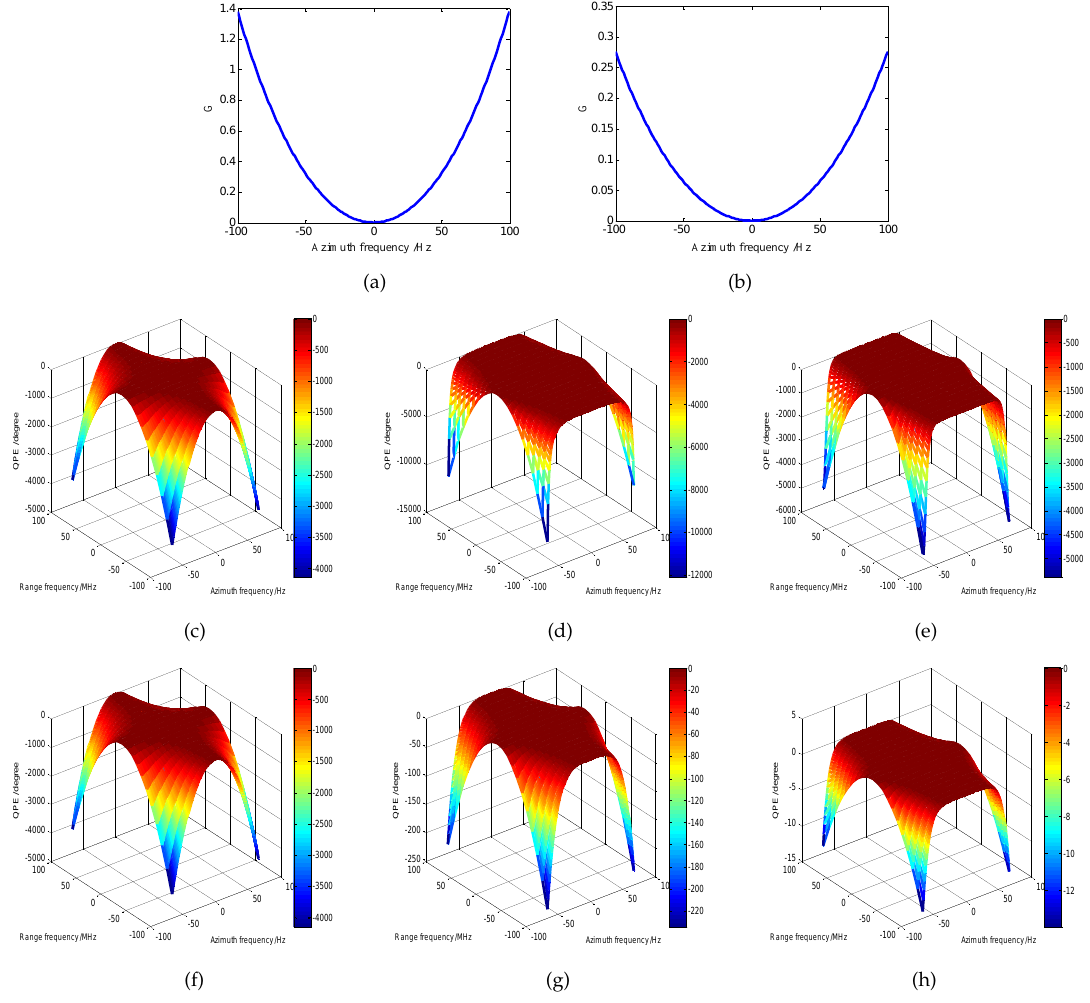
Figure 12. Parameters G and quadratic phase error (QPE). ( a ) Parameter G when T r = 2 us (TBP = 400). ( b ) Parameter G when T r = 10 us (TBP = 2000). ( c – e ) QPEs of zero-order, 1st-order and 2nd-order approximations corresponding to ( a ). ( f – h ) QPEs of zero-order, 1st-order and 2nd-order approximations corresponding to ( b